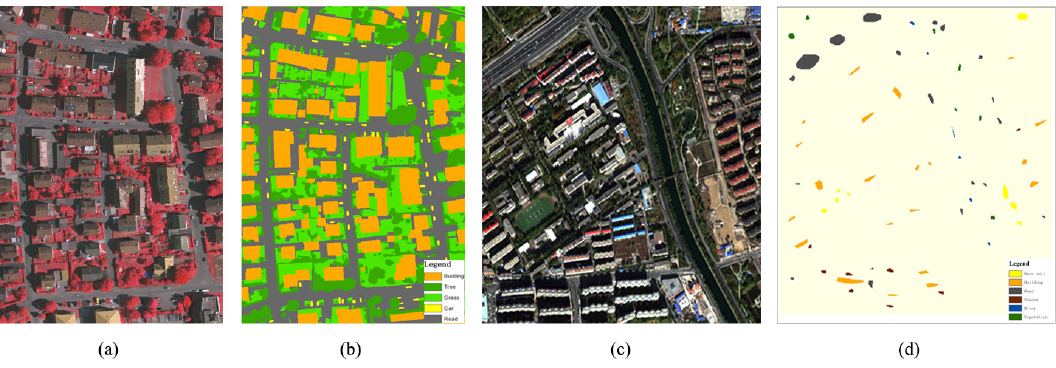
Figure 4. The illustration of experimental datasets and reference maps. ( a , b ) the Vaihingen dataset and its reference map, ( c , d ) the Beijing dataset and its reference map.